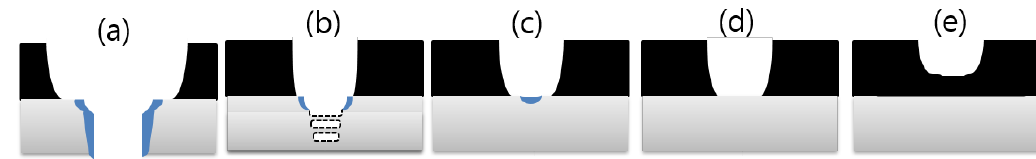
Figure 5. Variation of widths depending on laser power: ( a ) 250 W, ( b ) 200 W, ( c ) 150 W, ( d ) 100 W, ( e ) 50 W.